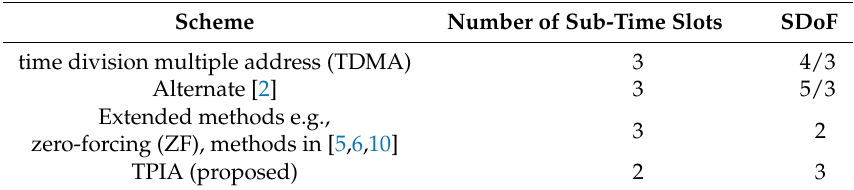
Table 2. Achievable SDoF comparison of different